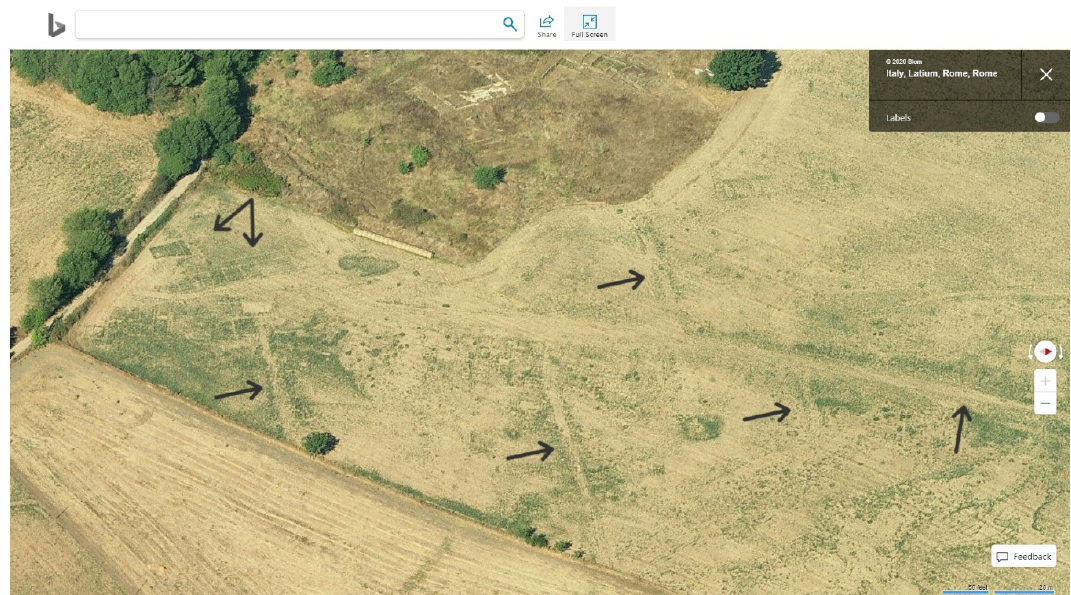
Figure 8. Example of archaeological cropmarks with three positive detections in the proximity of excavated structures of the ancient Etruscan city of Veii. This area has been much studied, e.g., by Ward-Perkins [59], and has been surveyed using geophysical prospection (magnetometry) by Campana [54]. Parallel lines running approximately North to South, and a wider line running East to West, have also been identified in the magnetometry survey of Campana, and have been interpreted as streets of the ancient city of Veii [54], while other cropmarks in between the streets show building foundations (see black arrows). The Microsoft product screenshot is reprinted with permission from Microsoft Corporation.